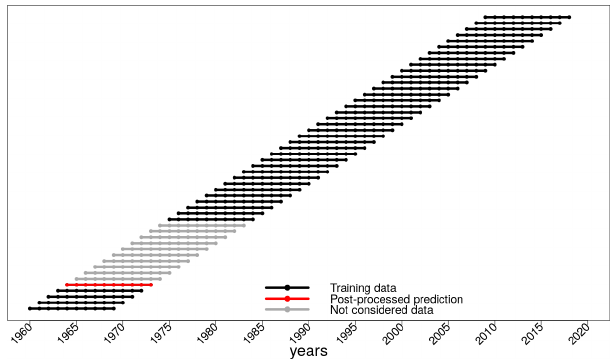
Figure 2. Schematic overview of the cross-validation setting for a decadal climate prediction, initialized in 1964 (dotted red line). All hindcasts which are initialized outside the prediction period are used as training data (dotted black lines). A hindcast which is initialized inside the prediction period is not used for training (dotted gray